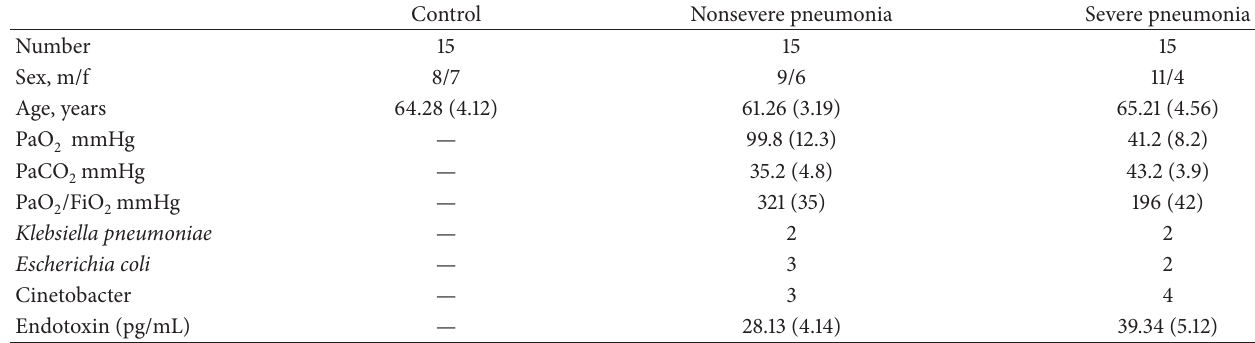
Table 1: Descriptive statistical analysis of the study